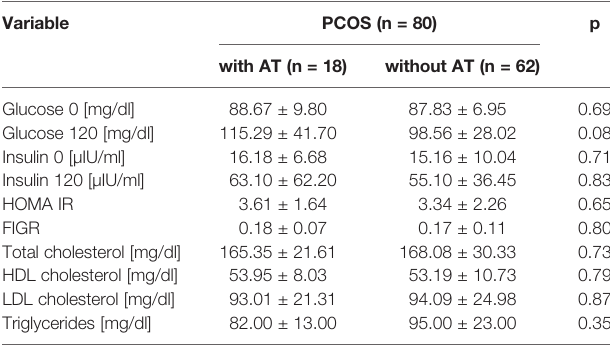
TABLE 2 | Comparison of biochemical parameters in the subgroups of PCOS patients: with AT vs without AT. Variable